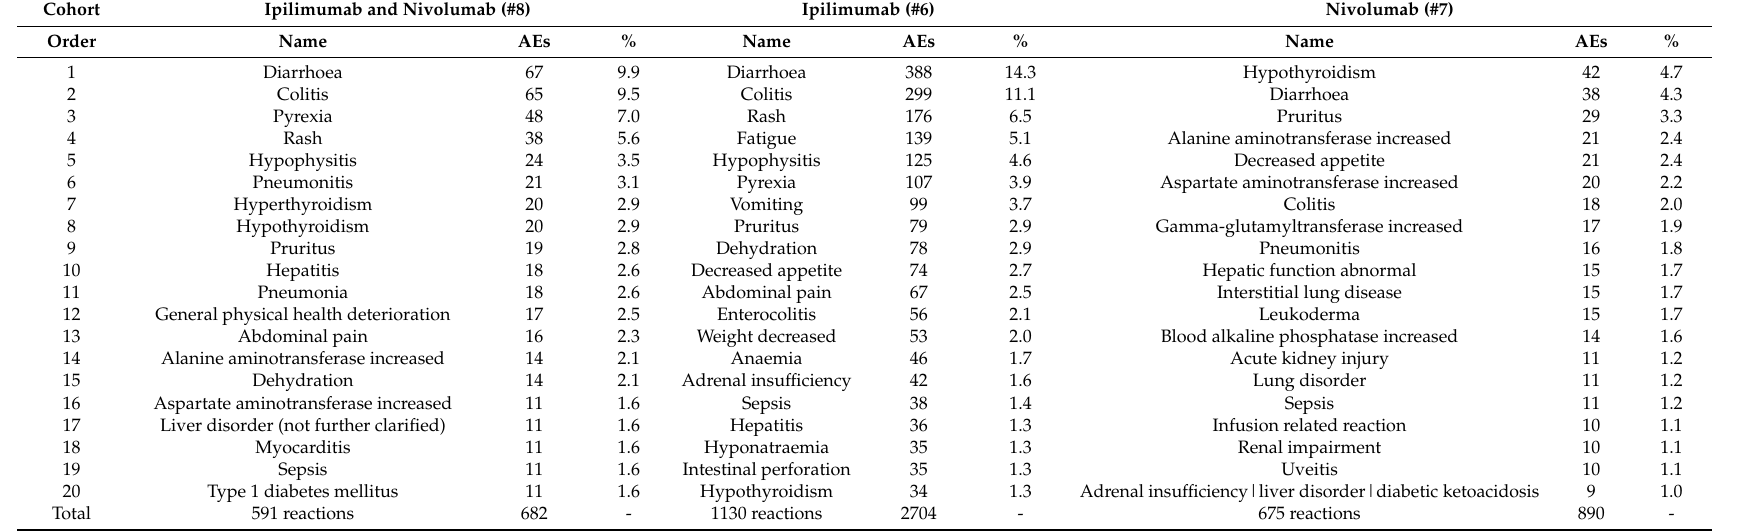
Table 1. Top twenty most frequently reported reactions in each ‘clean’ cohort (#6–#8). The table lists a total of forty reactions, most frequently reported in each cohort, after filtering for statistical significance (Fisher’s exact test p -value < 0.05), PRR signal > 1, and excluding terms either reflecting the patients’ disease or not describing physiological effects (namely, ‘transfusion’, ‘death’, ‘malignant neoplasm progression’, ‘neoplasm malignant’, ‘prescribed overdose’, ‘adverse event’, ‘inappropriate schedule of drug administration’). In total there were 1484 reaction terms reported in all three cohorts, indicating overlap between the mentioning of reactions in the sets: 1130, 675, and 591 reaction terms were reported in the 2704 AE of the ipilimumab (only), 890 AEs of nivolumab (only), and 682 AEs of the ipilimumab and nivolumab (only) cohorts,